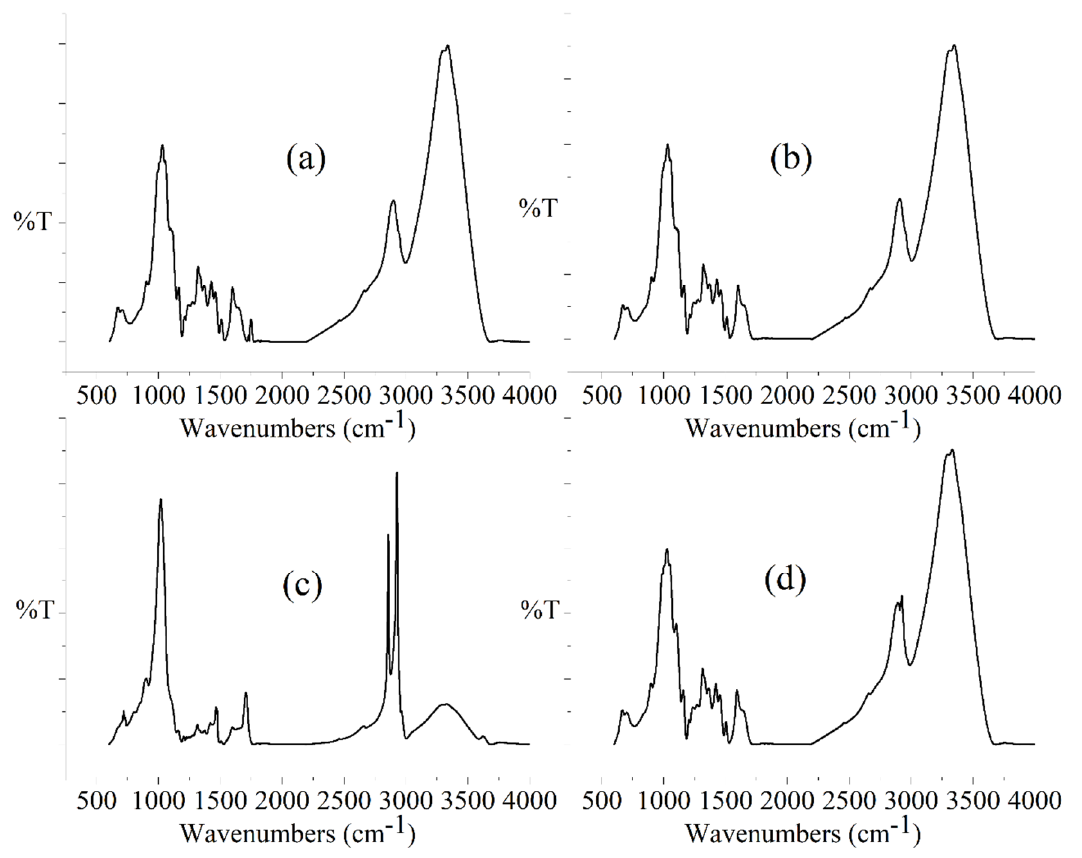
Figure 3. FESEM images of ( a ) JF un , ( b ) A-JF, ( c ) A-St-JF and ( d ) A-Si-JF.